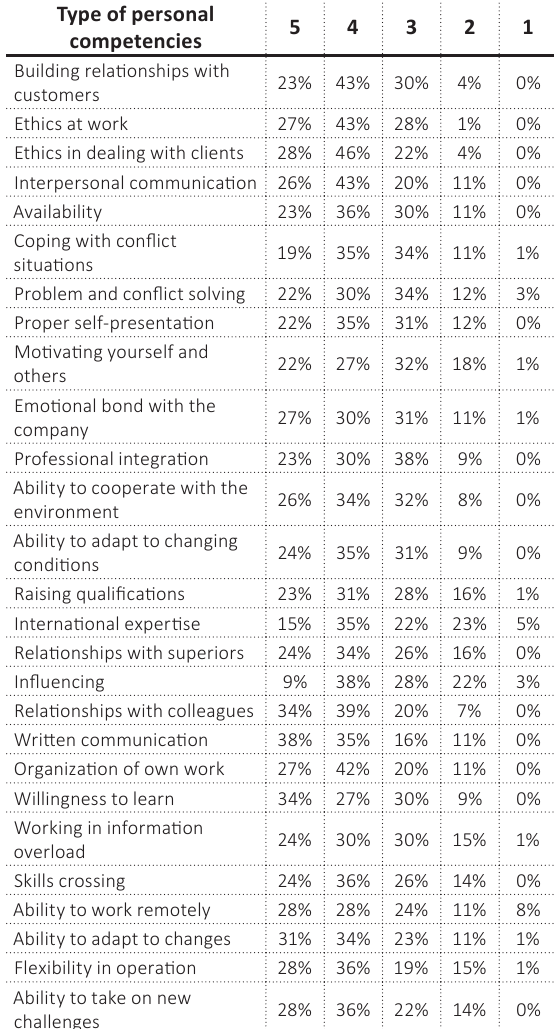
Source: Own study.